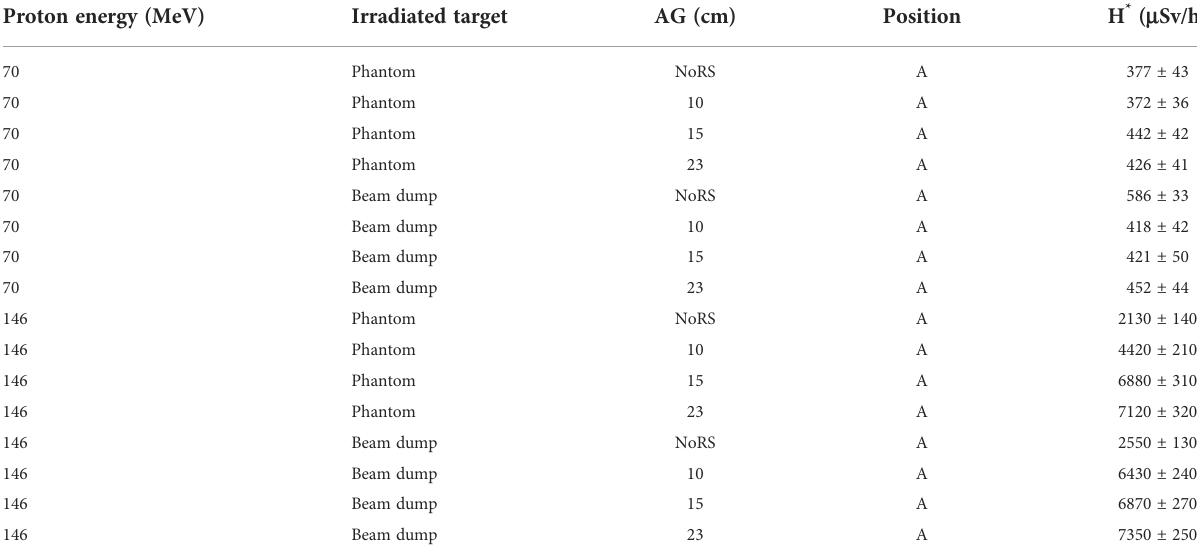
Either the phantom or a proton beam dump was irradiated, and irradiations were made either with a range shifter at a certain range-shifter position (AG), or without the range shifter (NoRS). The values are given with two signi fi cant fi gures and as mentioned in Section 2.4, the values are illustrated with statistical uncertainties only with k = 1. Effects from, e.g., uncertainties in gas pressure, detector dimensions, and the W value give an additional contribution of Figure 6. Included are also measured values, using the same Figure 5 illustrates the (cid:1) y D values for different range-shifter detectors, for neutrons, photons, and protons from Lillhök (18), settings, when both the phantom (Figures 5A, B) and the proton Kyllönen et al. (19, 21), and Kyllönen and Mayer (28), as well as beam dump (Figures 5C, D) were irradiated. When the phantom conversion coef fi cients to ambient absorbed doses from Ferrari was irradiated with 70-MeV protons, the (cid:1) y D values increased in and Pelliccioni (29) and Leuthold et al. (30). The conversion both positions when a range shifter was inserted. In the A coef fi cients from Ferrari and Pelliccioni were calculated as the position, the (cid:1) y D value seemed to be independent of the range- ratio of the reported H * conversion coef fi cient and the effective shifter position, while there was an increasing trend in the C position. The increasing (cid:1) y D value indicates an increasing dose quality factor at 10-mm depth in the ICRU sphere. A good agreement is seen between the simulated absorbed dose response contribution from a high-LET component.